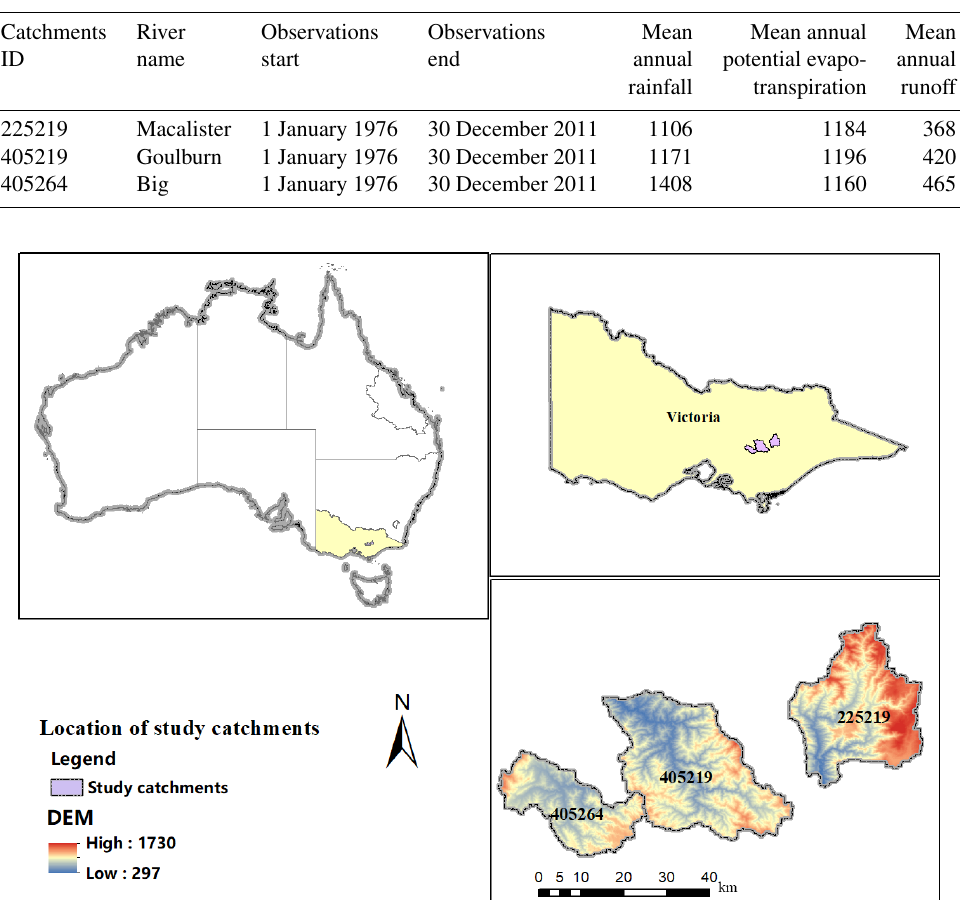
Figure 3. Locations of study catchments in Victoria, Australia. The catchment IDs are 225219 (Macalister River catchment), 405219 (Goul- burn River catchment), and 405264 (Big River